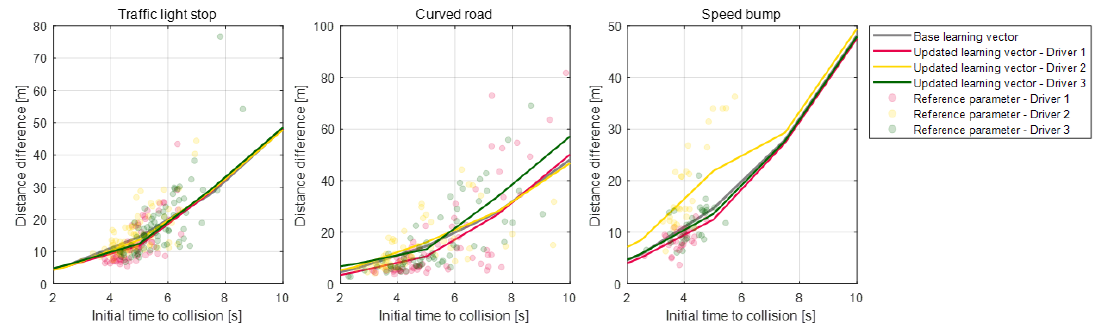
Figure 23. Learning results for parameter distance difference for each road